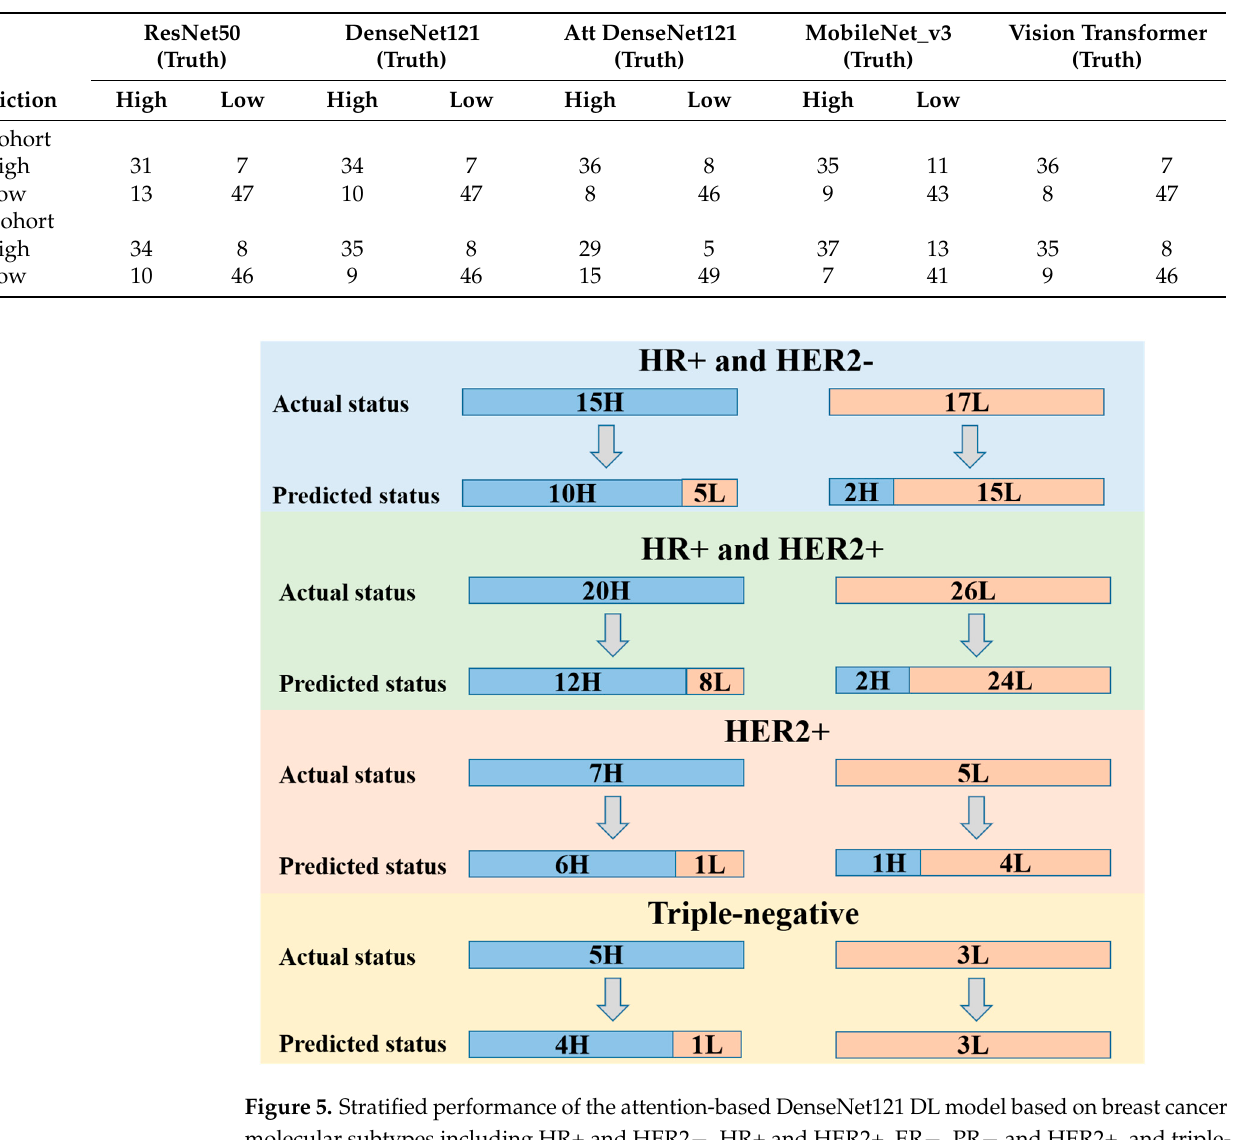
Table 3. Confusion Matrices for attention-based DenseNet121 DL model according to Validation cohorts.